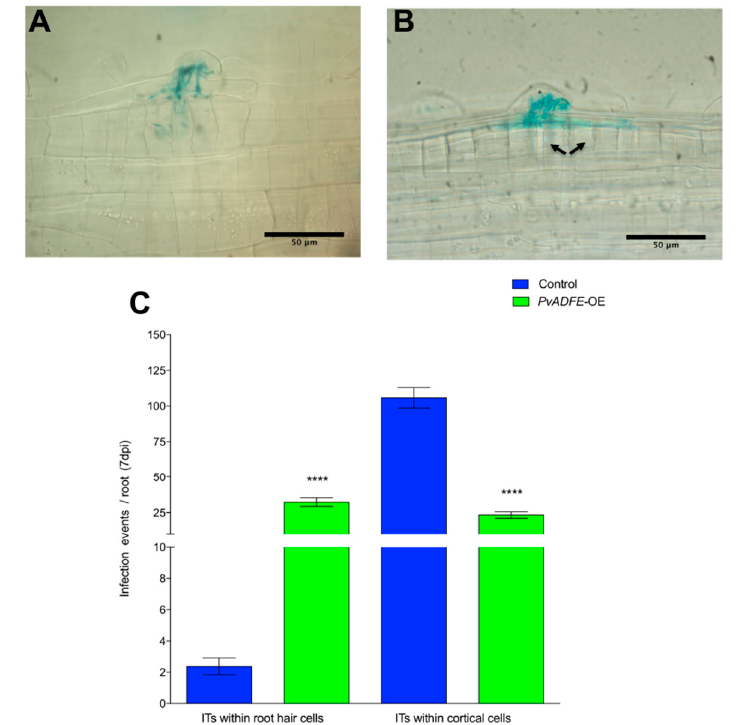
Figure 5. Infection events in root hairs of PvADFE -OE and control transgenic roots at 7 dpi with R. tropici expressing GUS. Micrographs show ( A ) branched ITs invading root cell layers in control transgenic roots and ( B ) ITs arrested within the epidermal cells in PvADFE -OE transgenic roots. Cortical cell division is indicated by black arrows. ( C ) Number of infection events per root in PvADFE -OE and control transgenic roots at 7 dpi. Values are mean ± SEM with n > 9 roots per each condition. **** p < 0.0001 according to Student’s t -test. Bars ( A , B ), 50 µm.